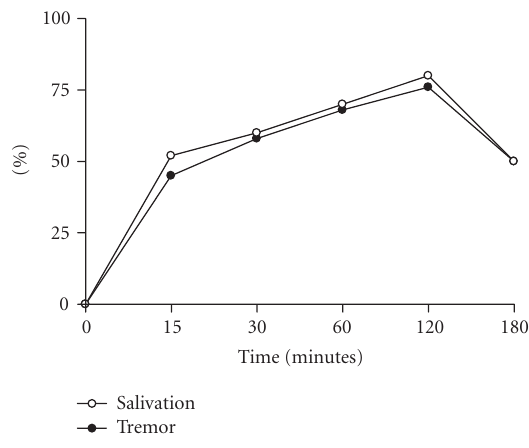
Figure 3: Symptoms. Groups of 15 female mice from the BALB/c strain, 16–20 g of body weight, were injected subcutaneously with 1 LD 50 of CSV. Each point represents the percent animal number with salivation and/or tremor. The experiment was repeated twice and each point represents the values of pooled sera from 5 animals (cid:0)